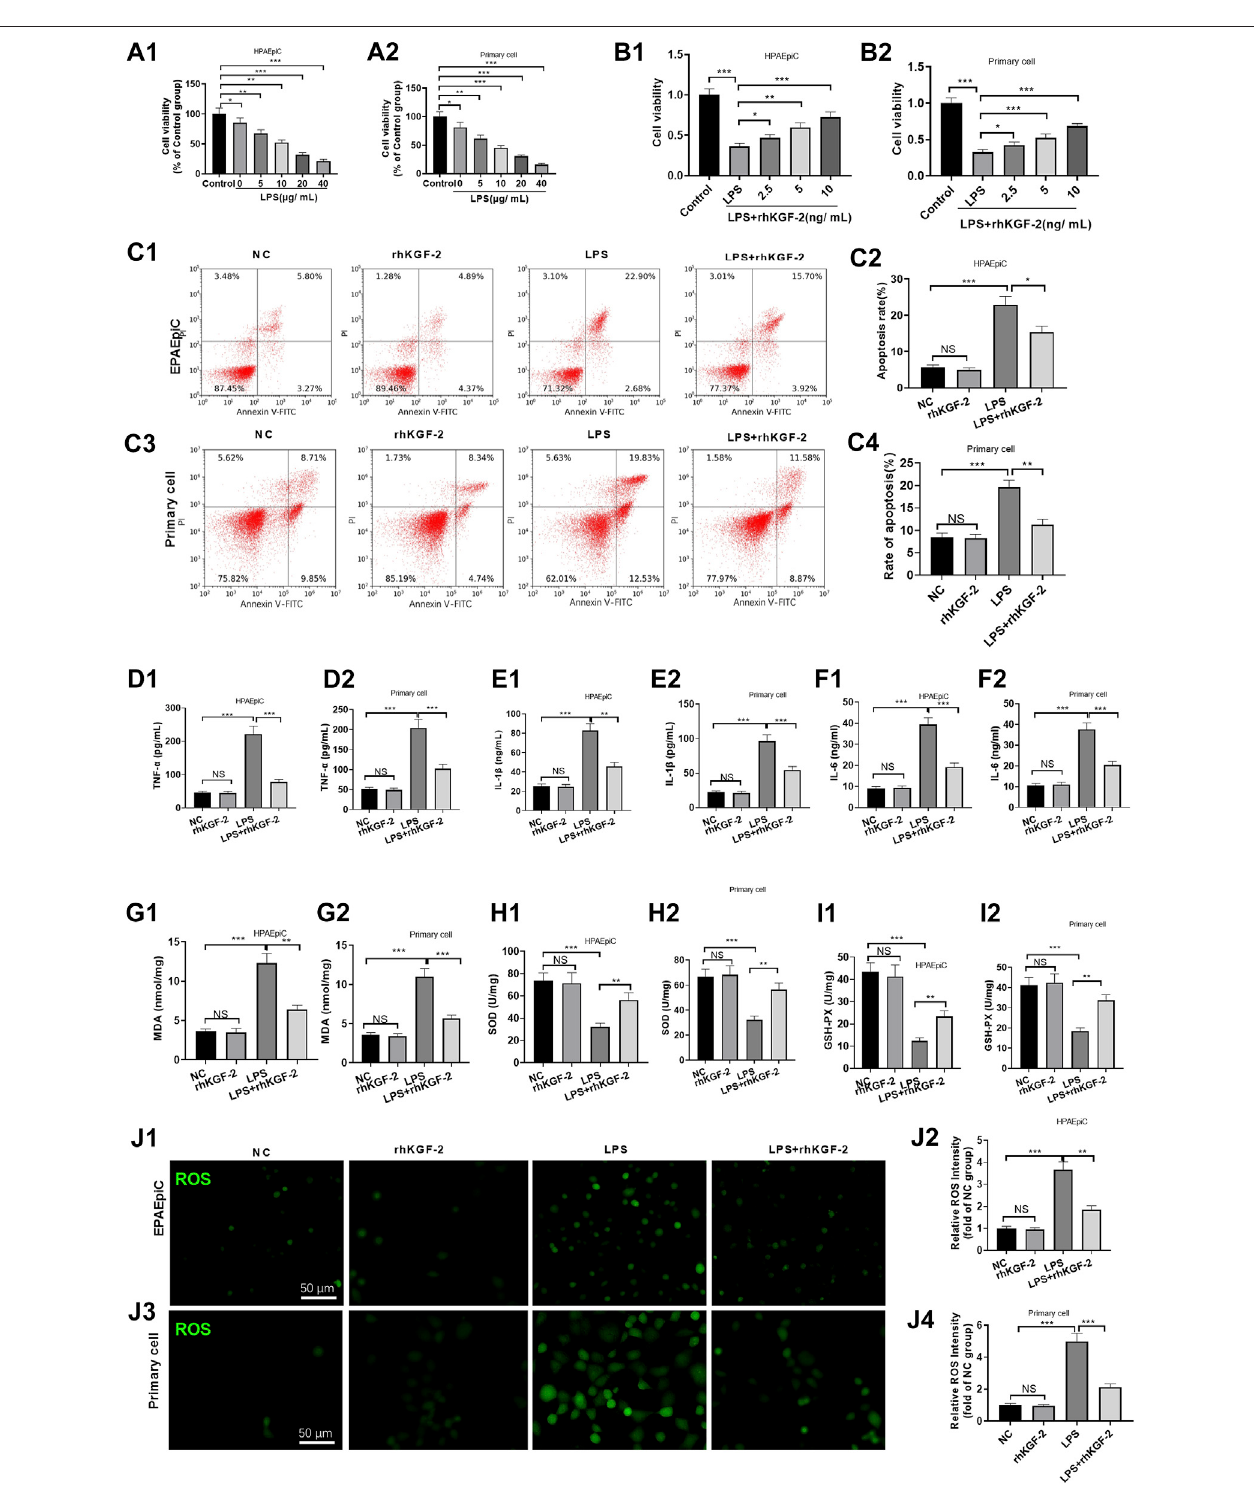
FIGURE 1 | The effect of rhKGF-2 on the cell viability, apoptosis, in fl ammation, oxidative and ROS generation of alveolar epithelial cells with LPS treatment. The HPAEpiC cells and primary rat alveolar epithelial cells were treated with LPS (5 – 20 μ g/ml) and rhKGF-2 (2.5 – 10 ng/ml) for 24 h. A,B : Cell viability was determined by the MTT assay. The HPAEpiC cells and primary rat alveolar epithelial cells were treated with LPS (10 μ g/ml) and rhKGF-2 (10 ng/ml) for 24 h. A1, A2, B1, B2 : MTT assay were implemented to verify cell viability. The cell viability was calculated as the relative fold change of control group; C1 – C4 : FCM was conducted to analyze